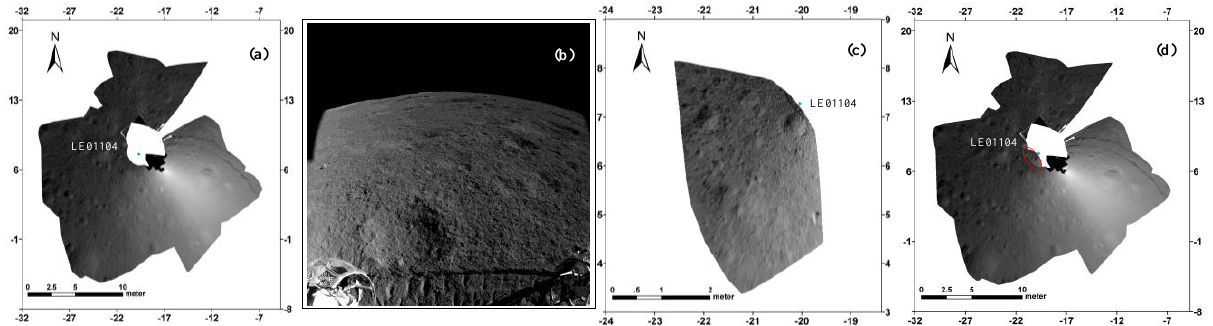
Figure 8. The DOMs and Hazcam image at waypoint LE01104: (a) Automatically generated DOM from Navcam stereo images; (b) Left Hazcam image; (c) Automatically generated DOM from Hazcam stereo images; (d) DOM after